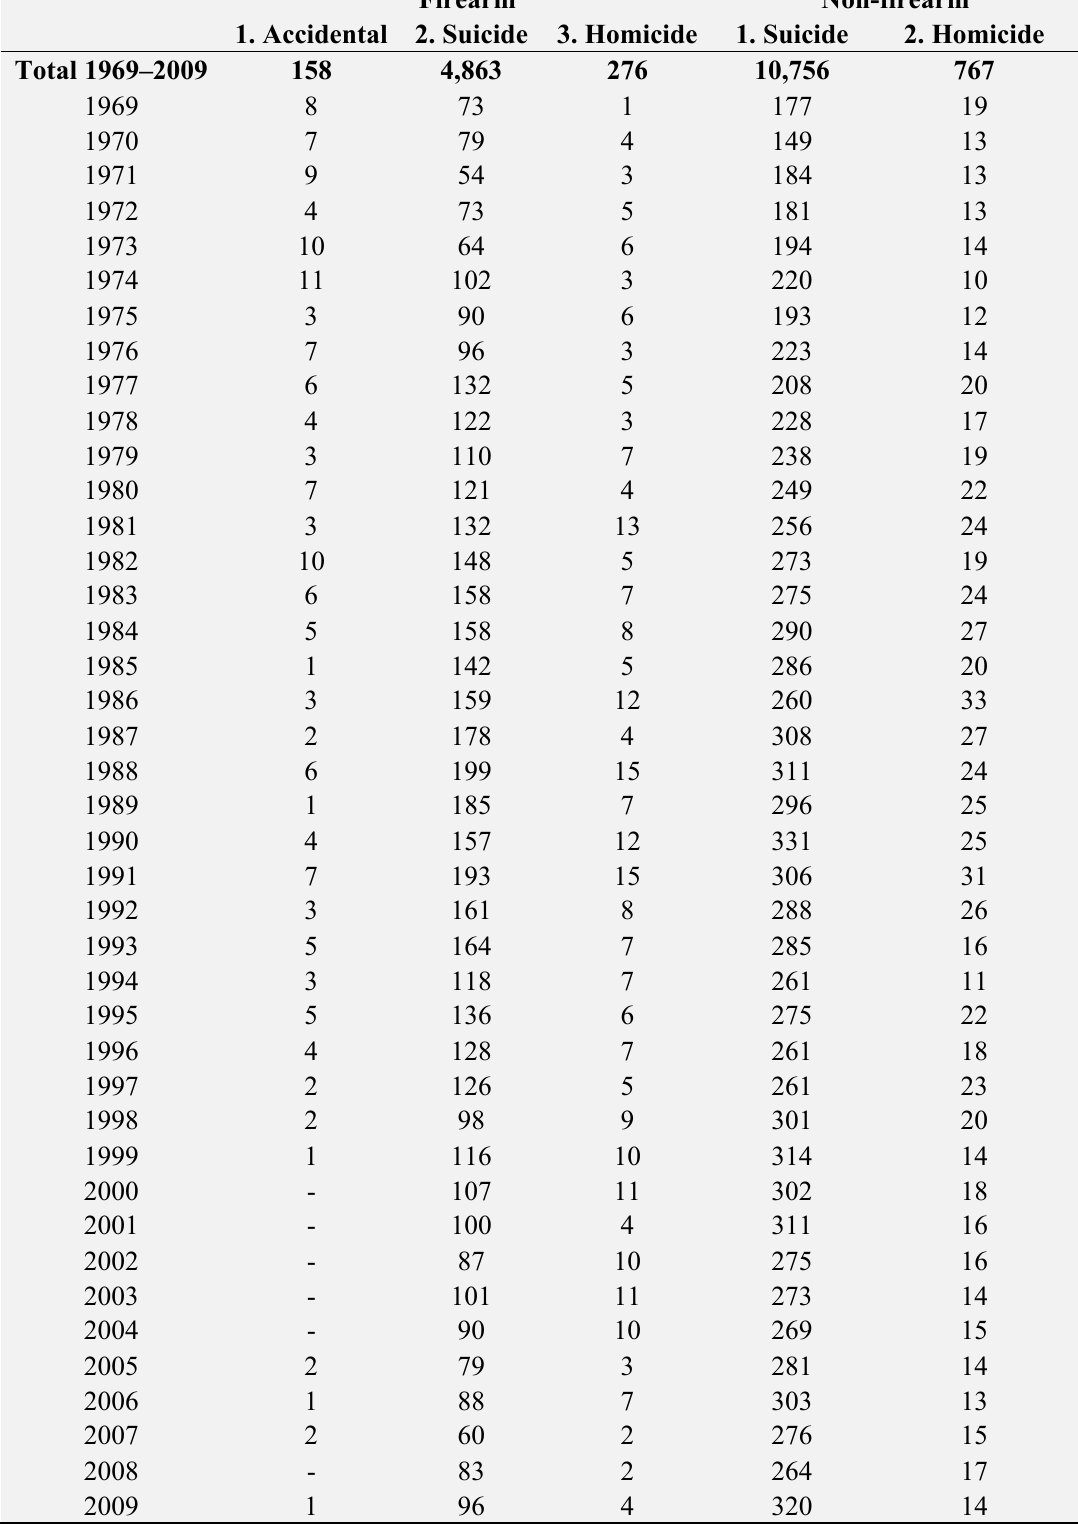
Table 2. Male deaths divided into three firearm injury categories and two non-firearm injury categories. These data were used in the Poisson